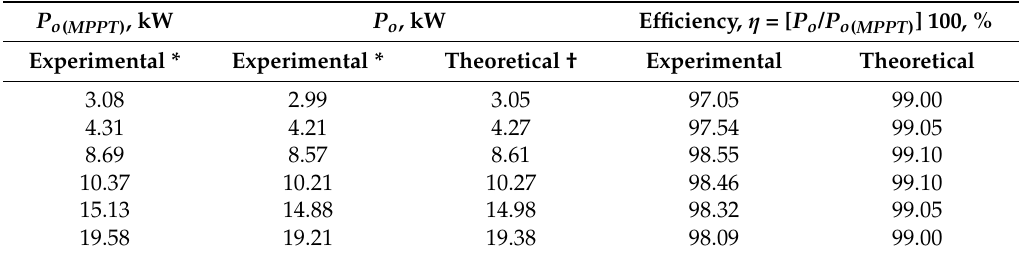
Table 5. Comparison of experimental and theoretical efficiency values of SiC inverter.